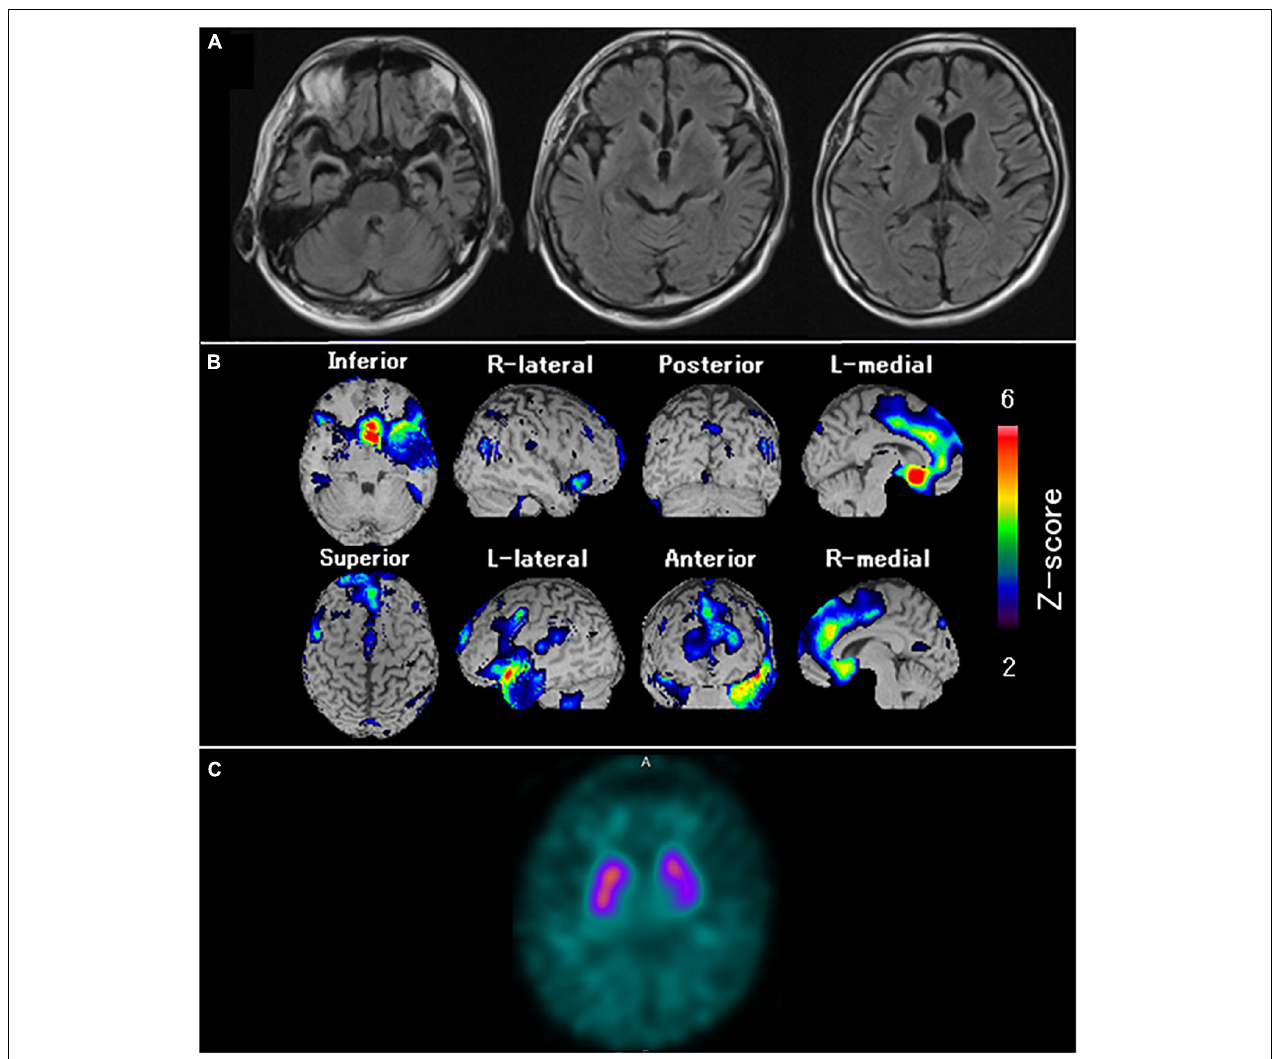
FIGURE 8 | Neuroradiological findings in Case 6. (A) Magnetic resonance imaging shows marked bilateral anterior temporal lobe atrophy, predominant on the left side and the orbitofrontal cortex. (B) Brain perfusion single photon emission computed tomography (SPECT) easy Z-score Imaging System analysis (FUJIFILM Toyama Chemical Co., Ltd., Tokyo, Japan) shows significant hypoperfusion in the bilateral anterior temporal lobes, predominantly in the left side, the orbitofrontal cortex, and the medial frontal lobe. The color scale for the Z-score is shown on the right side of the figure. Presented in color if the Z-score was > 2. (C) Dopamine transporter (DAT) SPECT shows reduced DAT availability in the bilateral striatum, predominant on the left